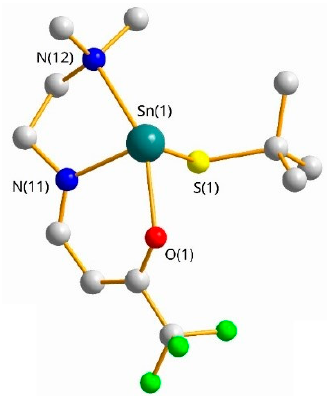
Figure 1. Molecular structure of [Sn(SBu t )( tfb-dmeda )] 1 . In the basal plane, the N(11)-Sn(1)-S(1) bond angles [83.12(6)-84.93(7)°] are more